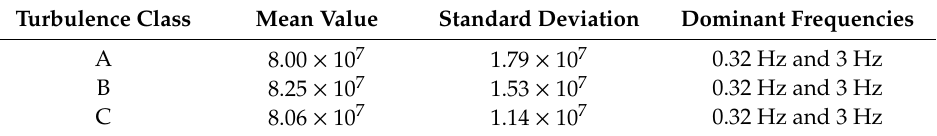
Table 5. Statistical analysis for tower-base bending moment in turbulent cases.